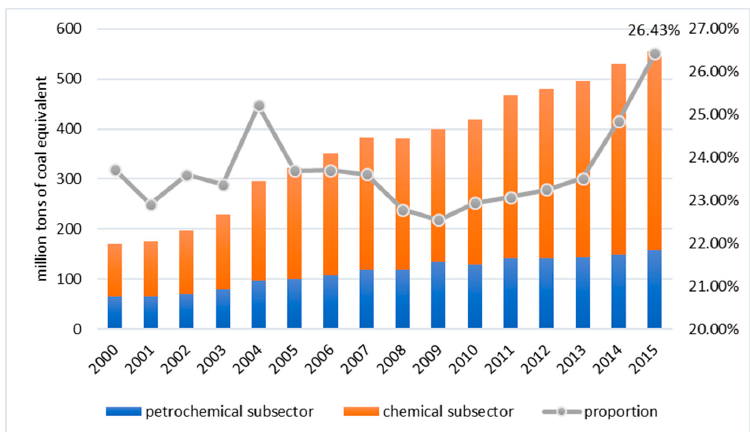
Figure 2. Final energy consumption in the petrochemical and chemical subsector. Final energy